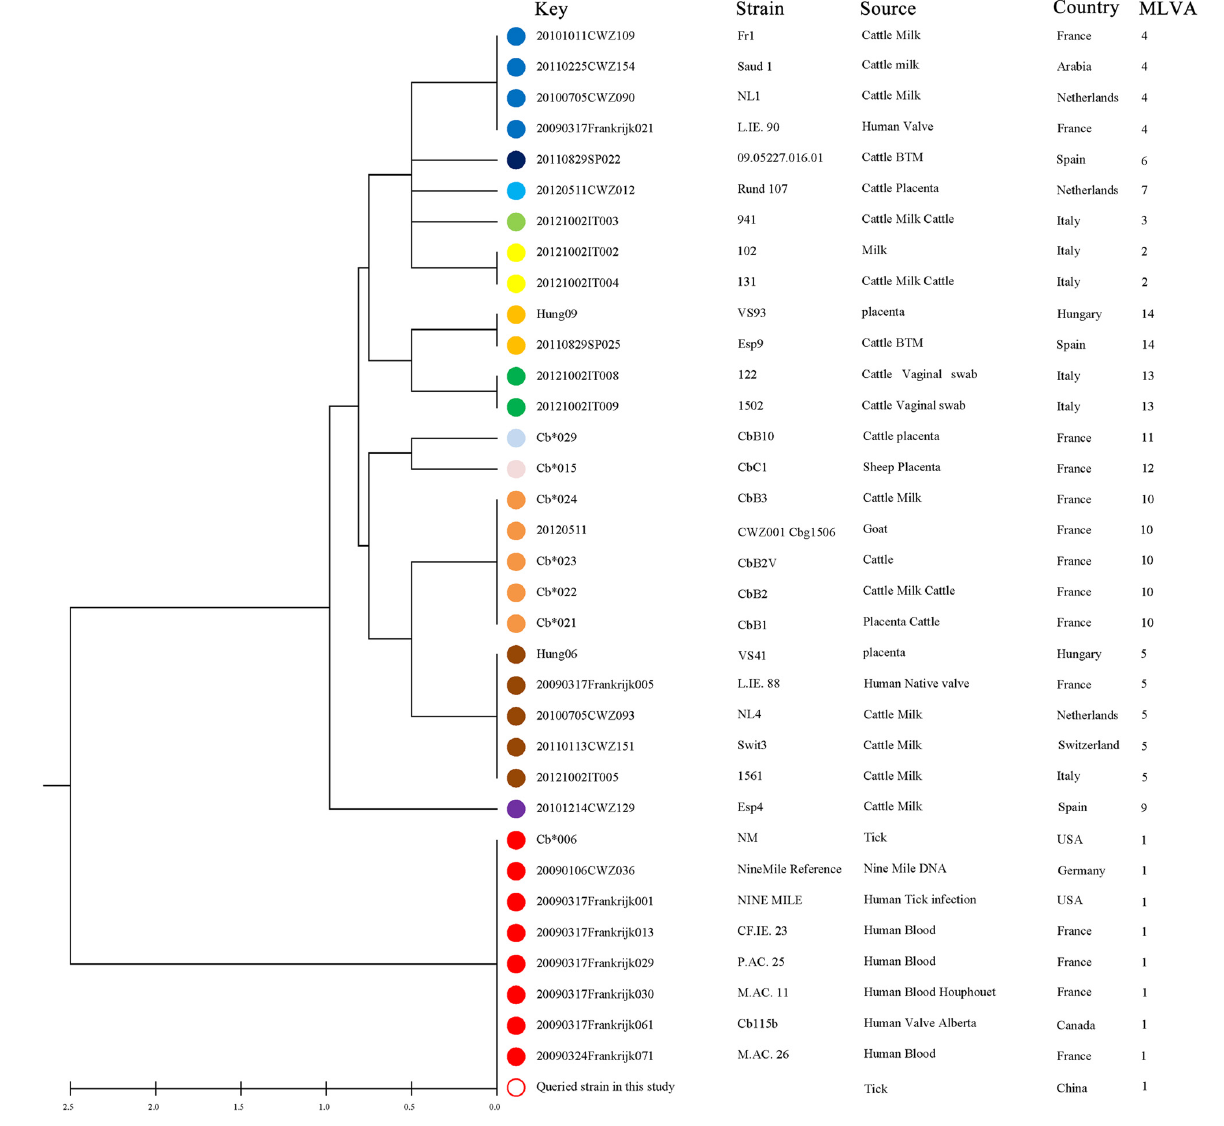
Frontiers in Microbiology |